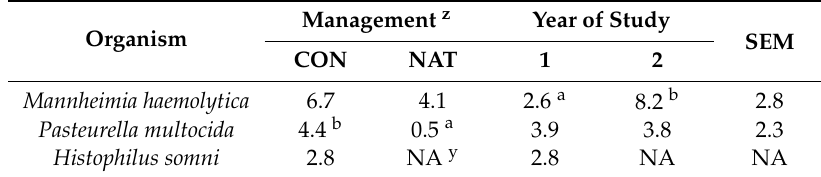
Table 3. E ff ect of year and feedlot management on numbers of AMR-related genes detected by PCR in isolates of Mannheimia haemolytica and Pasteurella multocida from lung tissue of bovine respiratory disease